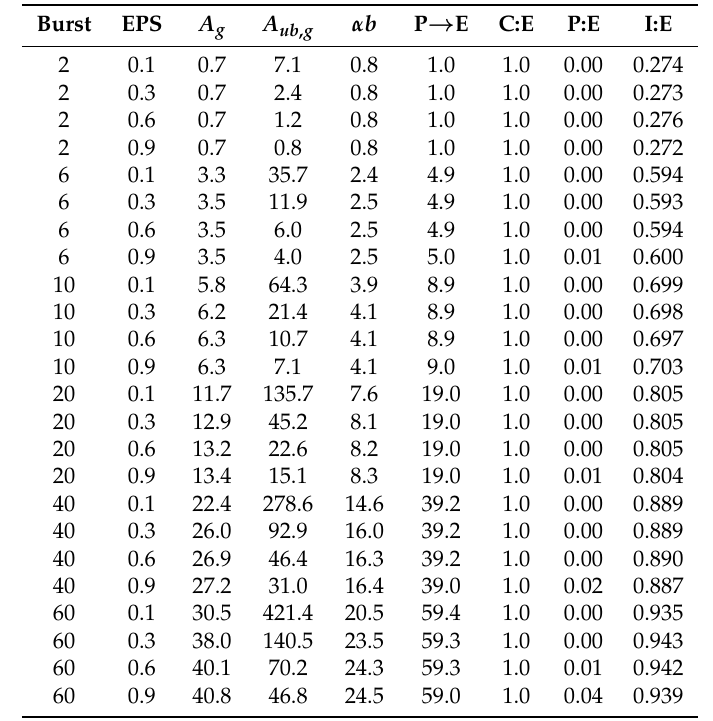
Table 3. Spatial grid model outcomes with deterministically clustered EPS, no superinfection or